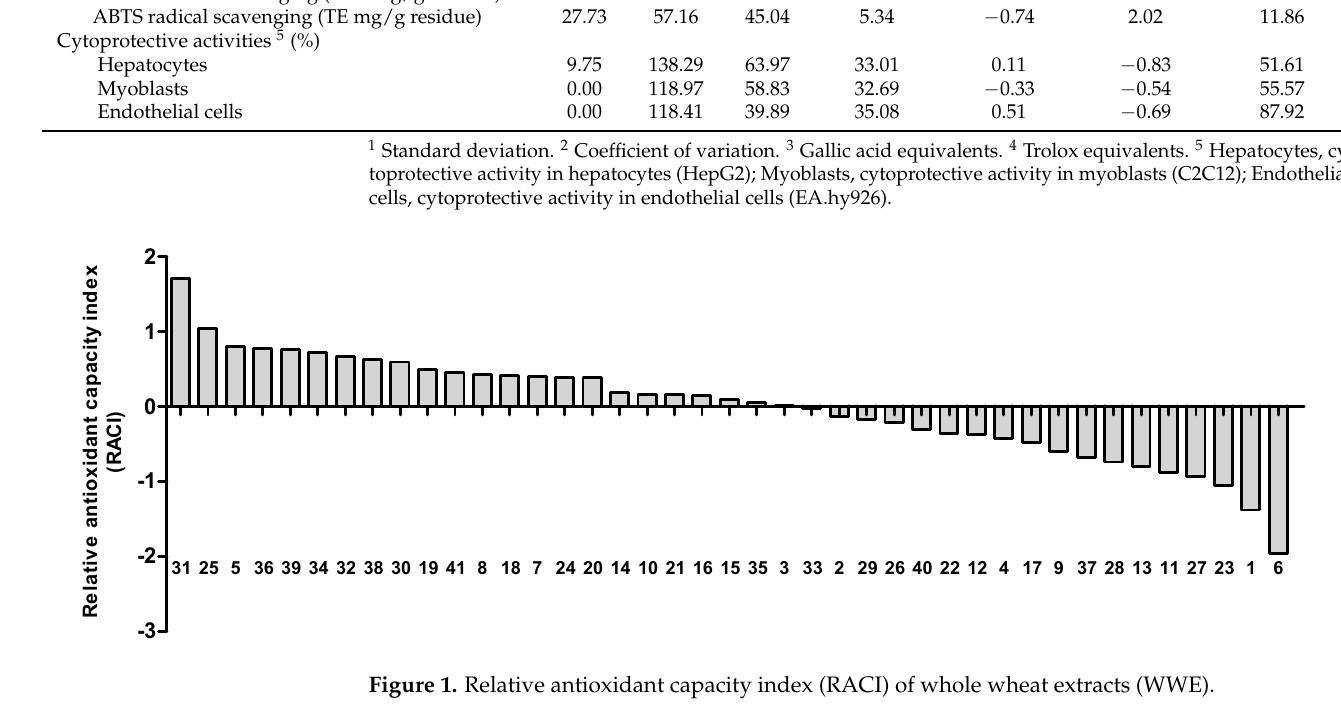
Figure 1. Relative antioxidant capacity index (RACI) of whole wheat extracts (WWE). The cytoprotective effect of WWE was observed on different cell lines, such as hepato- cytes (HepG2), myoblasts (C2C12), and endothelial cells (EA.hy926). WWE had the